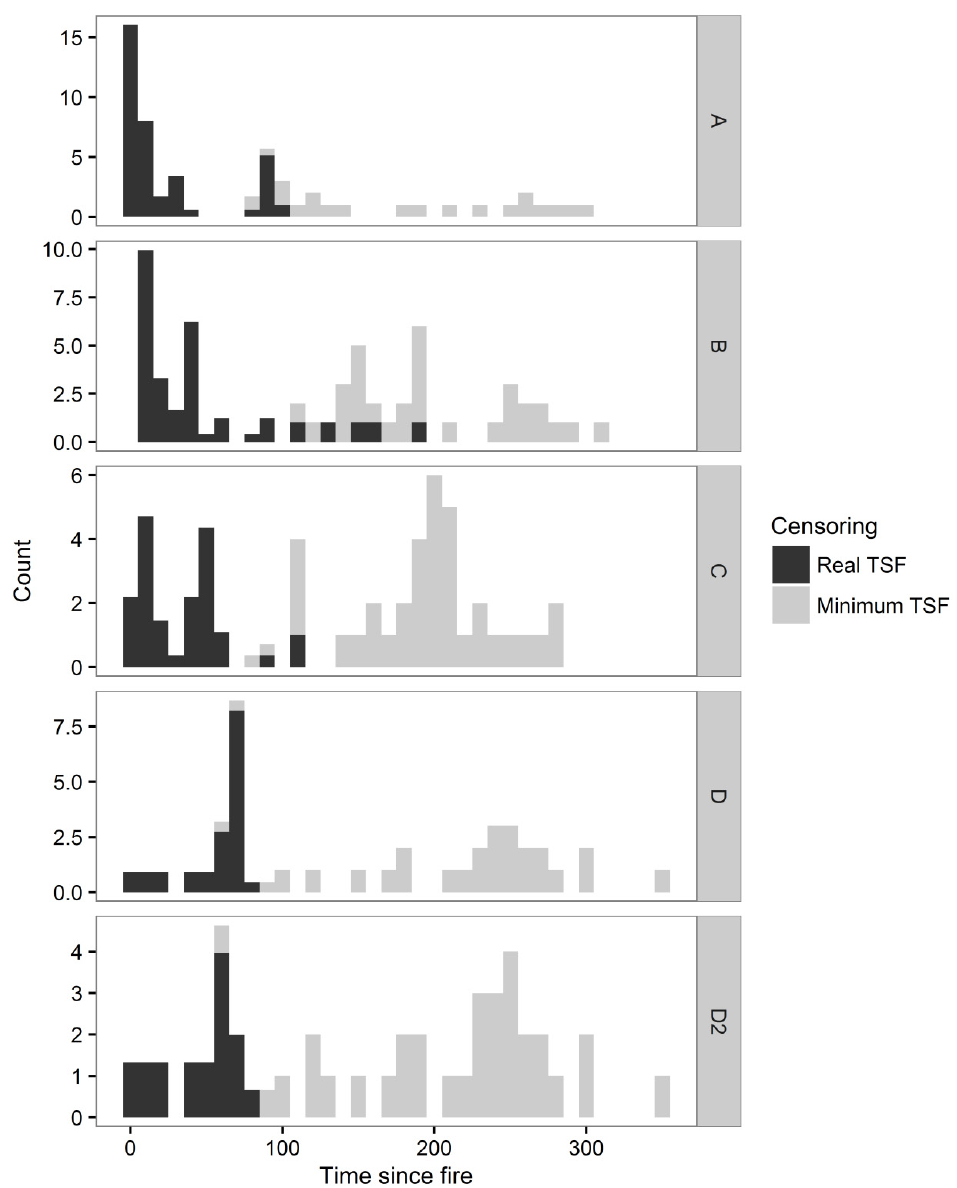
Figure 4. Decadal weighted frequency distribution of TSF for each transect. Weights are calculated in the same way that they were in the survival analyses in order to compensate for the over-representation of recent fires (after 1924) in transects. The non-weighted frequency distribution of TSF is presented in Figure A2. The proportion of right-censored data (minimum TSF) and real TSF are shown in grey and black, respectively.